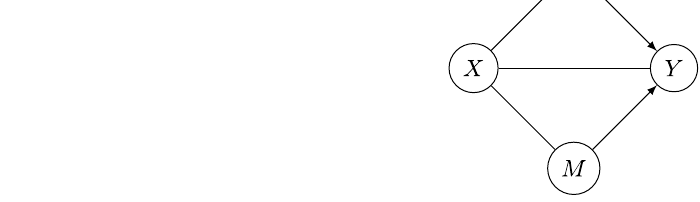
Figure 3: Equivalence class of graphs constructed from probability distribution in Table